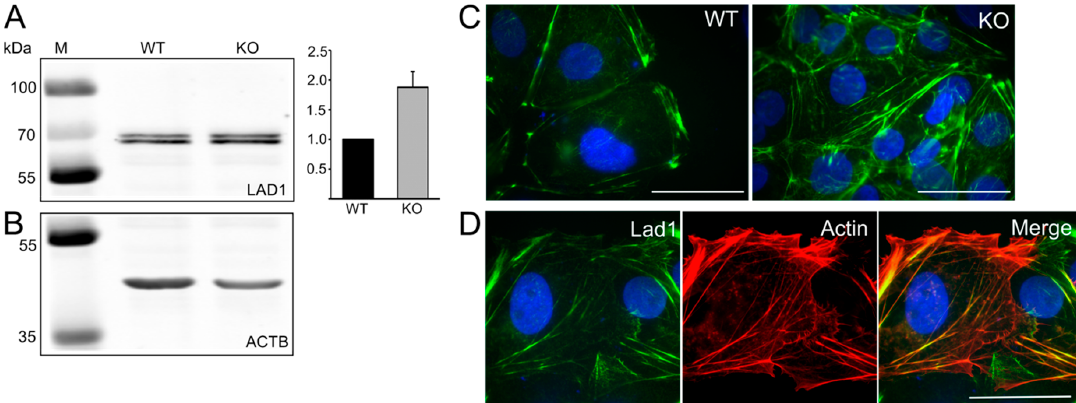
Figure 6. Expression and localization of LAD1 in TCam-2 wildtype (WT) and FLNA-deficient (KO) cells. ( A ) Western blot analysis of LAD1 in TCam-2 WT and FLNA-KO cells. ( B ) Loading control ACTB. LAD1 protein levels were normalized to the loading control ACTB and the quantification revealed an increase in LAD1 (histogram on the right). The upper band detected by the LAD1 antibody most probably represents phosphorylated LAD1 [39] . ( C ) Immunofluorescence localization of LAD1 in TCam-2 WT and FLNA-KO cells. ( D ) Partial co-localization of filamentous actin (red) and LAD1 (green) in FLNA-KO cells. Scale bars: 50 µm.